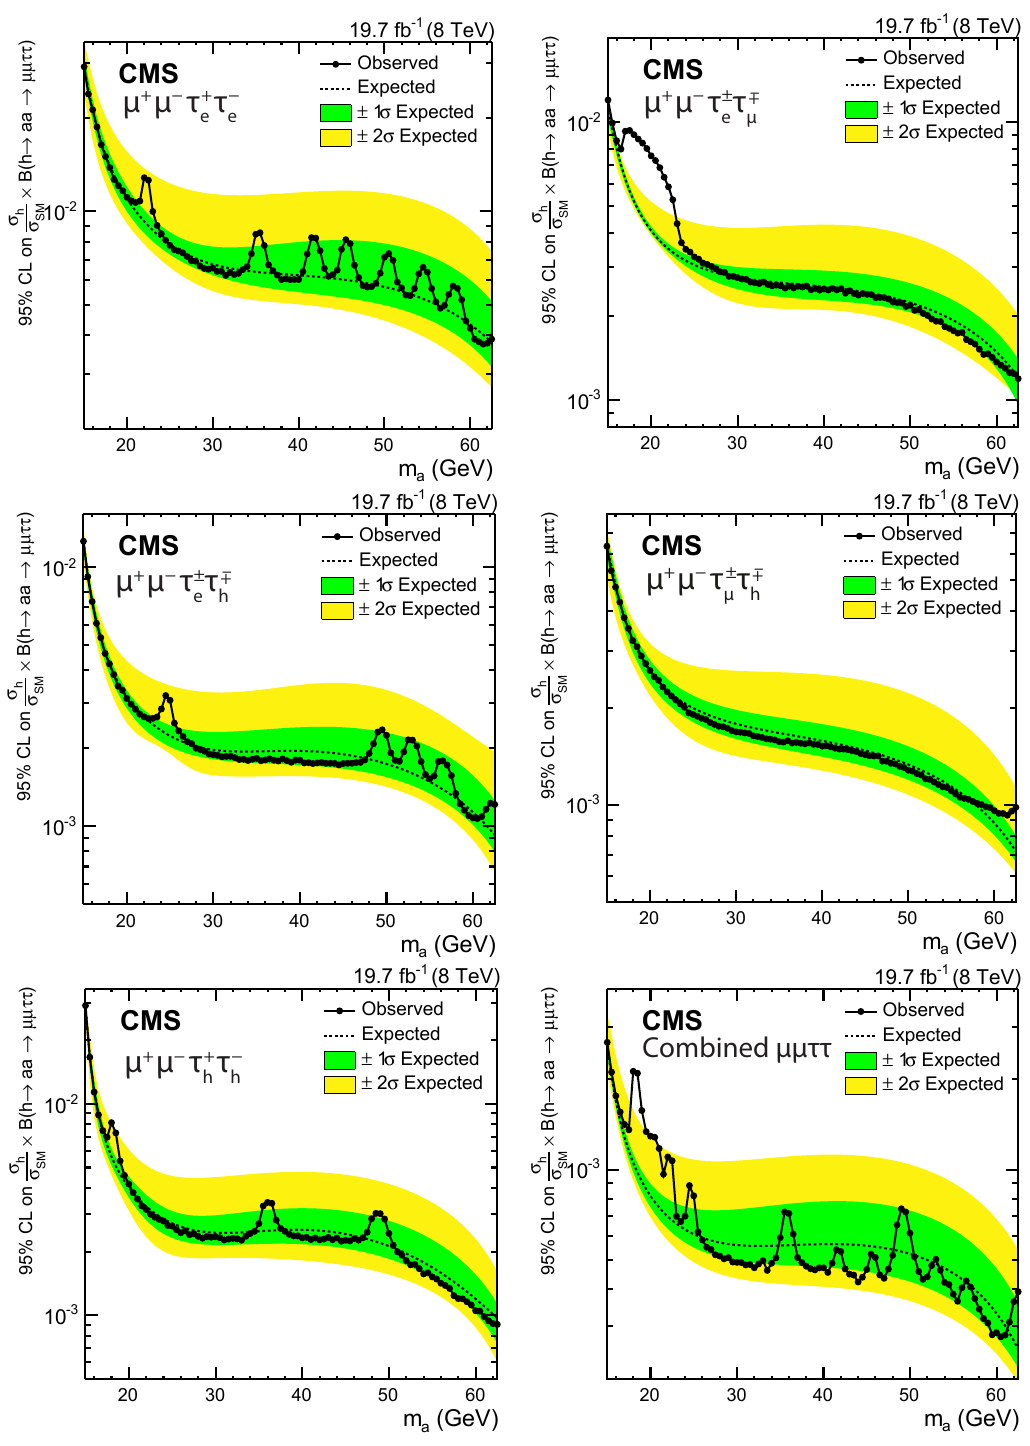
Figure 6 . Expected and observed upper limits at 95% CL on the h boson production normalized to the SM prediction times B (h ! aa ! 2 (cid:22) 2 (cid:28) ) in the (cid:22) + (cid:22) (cid:0) (cid:28) + (cid:28) (cid:0) (upper left), (cid:22) + (cid:22) (cid:0) (cid:28) (cid:6) (cid:28) (cid:7) (upper e e e (cid:22) right), (cid:22) + (cid:22) (cid:0) (cid:28) (cid:6) (cid:28) (cid:7) (middle left), (cid:22) + (cid:22) (cid:0) (cid:28) (cid:6) (cid:28) h (cid:7) (middle right), and (cid:22) + (cid:22) (cid:0) (cid:28) h + (cid:28) h (cid:0) (lower left) (cid:12)nal e (cid:22) h states, and for the combination of these (cid:12)ve (cid:12)nal states (lower right). None of the event excesses exceed two standard deviations in global signi(cid:12)cance.